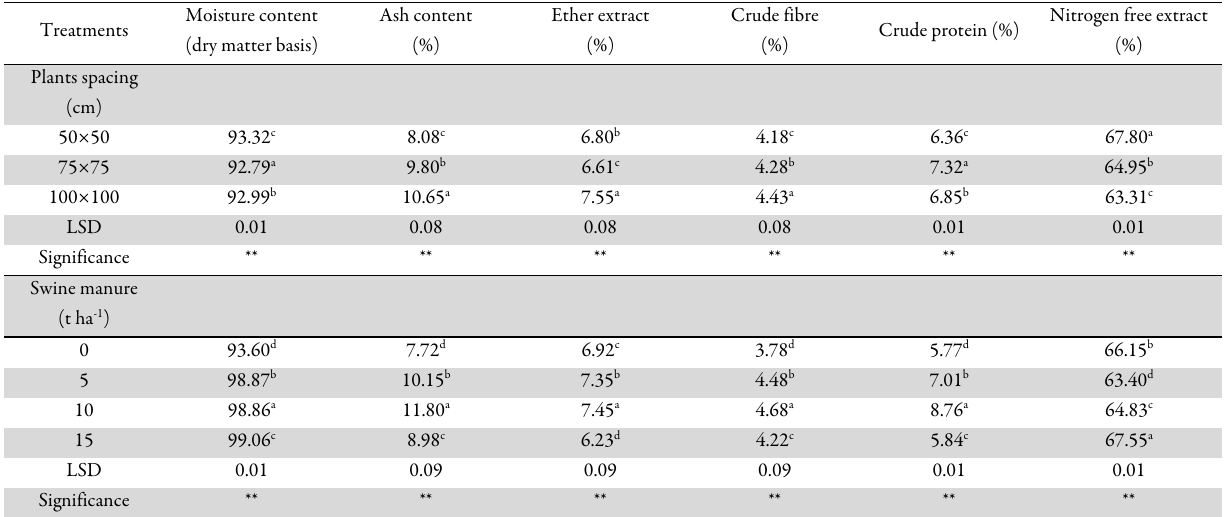
Table 4. Effects of spacing and levels of swine manure application on proximate composition of muskmelon Treatments